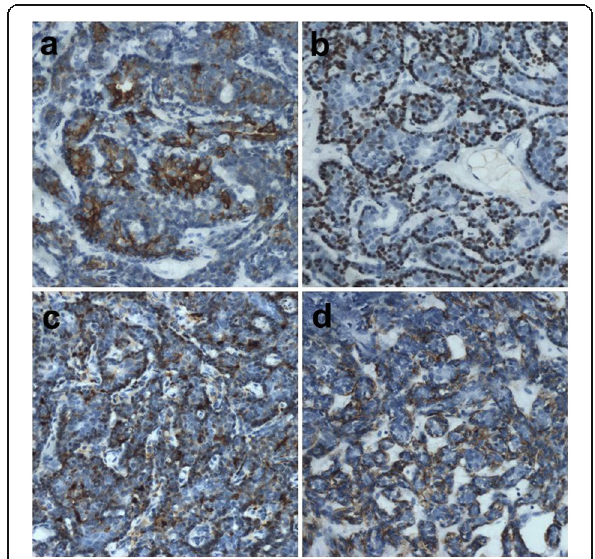
Fig. 3 Immunohistochemical findings( a ) cytokeratins 8 (× 200) ( b ) P63 (× 200) ( c ) S-100(× 200) ( d ) SMA (× 200)